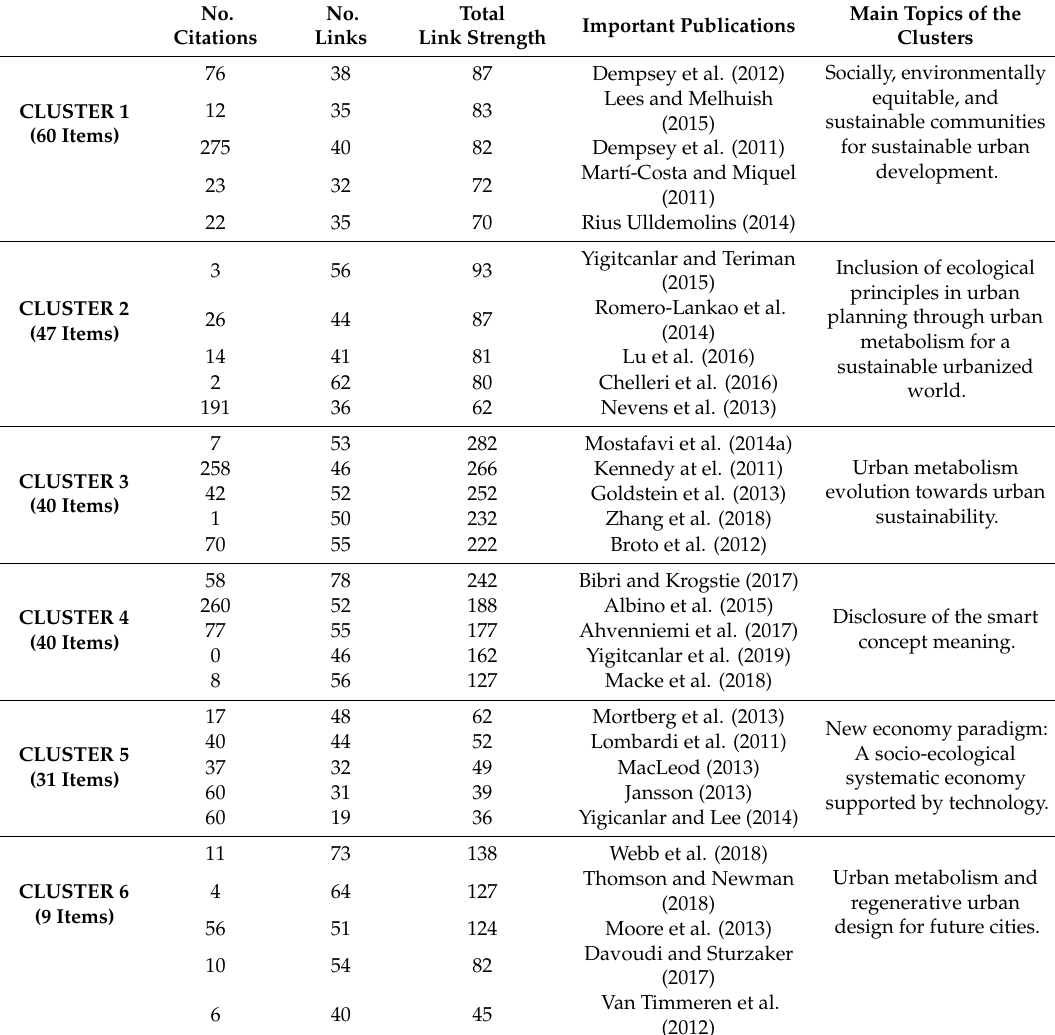
Table 4. Top five publications per infometric cluster with stronger links based on bibliographic coupling analysis. References can be found in Table